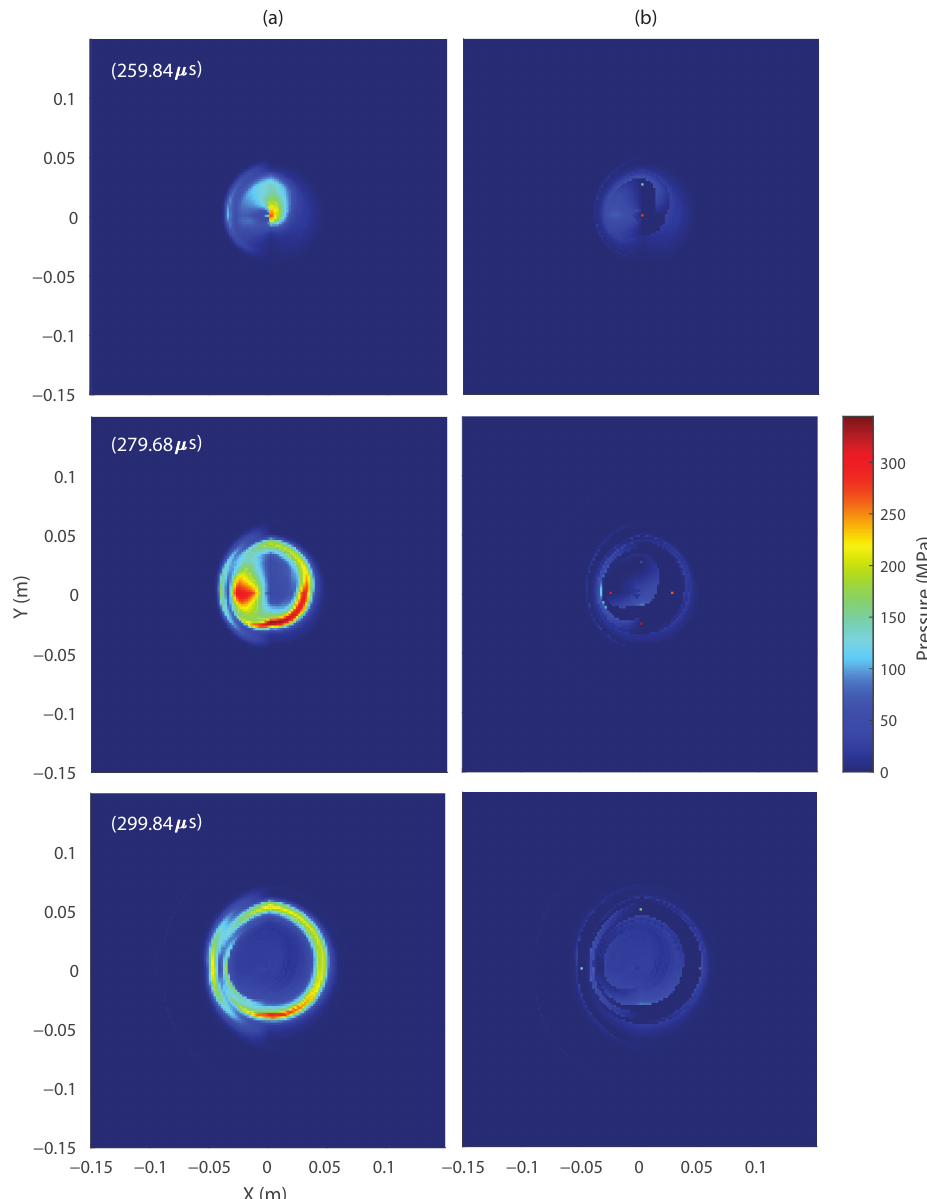
Figure 15. Test15 (LB) pressure surfaces over a 40 µs period: ( a ) Original and ( b ) Area-Limited